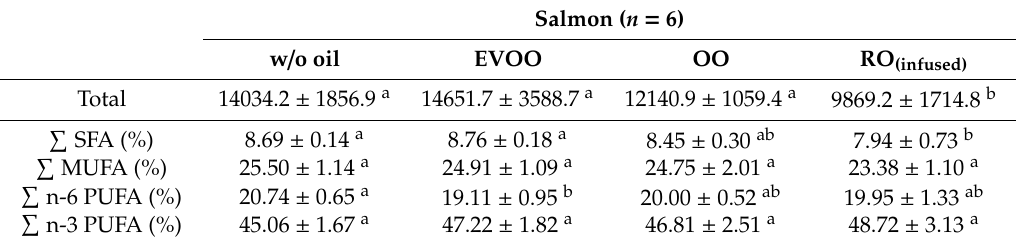
Table 1. Fatty acids content in pan-fried salmon ( µ g of analytes per g of salmon meat) cooked with or without extra virgin olive oil (EVOO), olive oil (OO), or rosemary-infused oil (RO (infused))